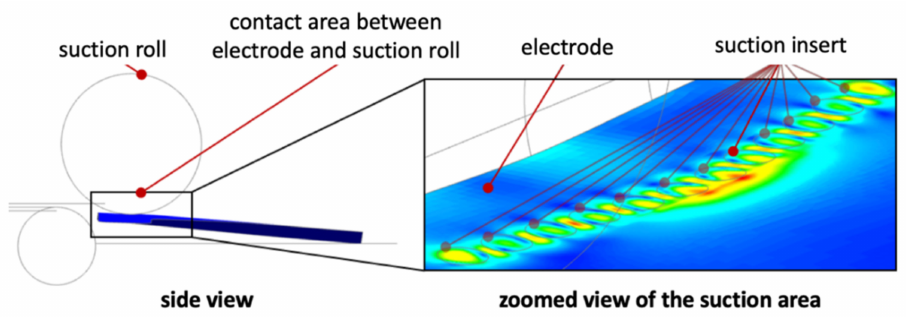
Figure 7. Detailed view on the optimized contact area from the air inlet of the suction roll and the